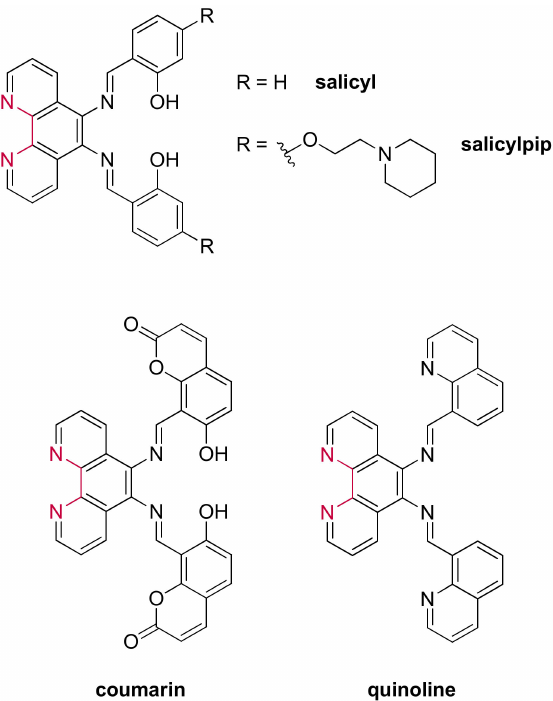
Figure 25. Structure of the Schiff base ligands used to form the ruthenium(II) complexes studied in the presence of